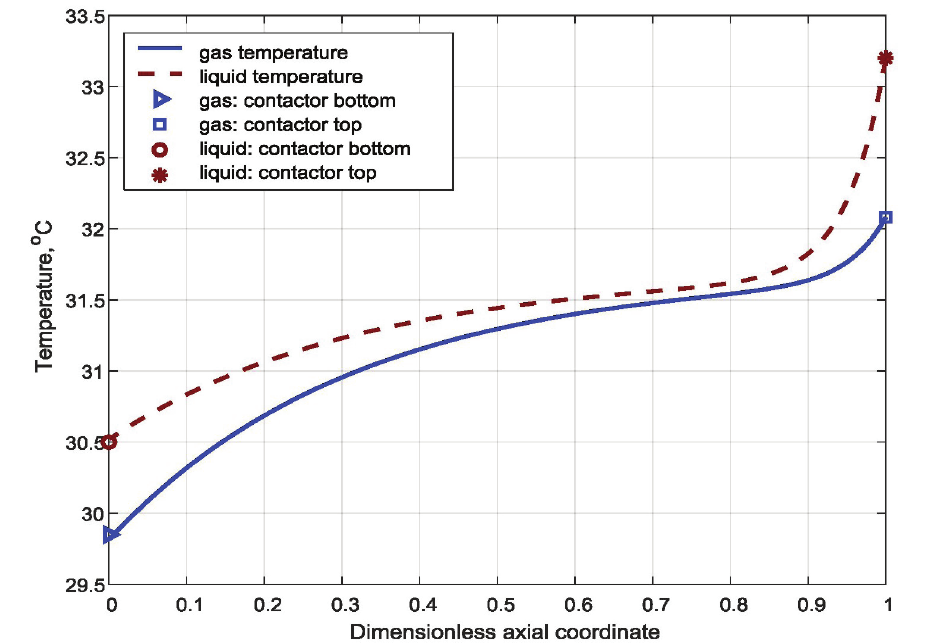
Fig. 7b – Example 2. Gas and liquid temperature